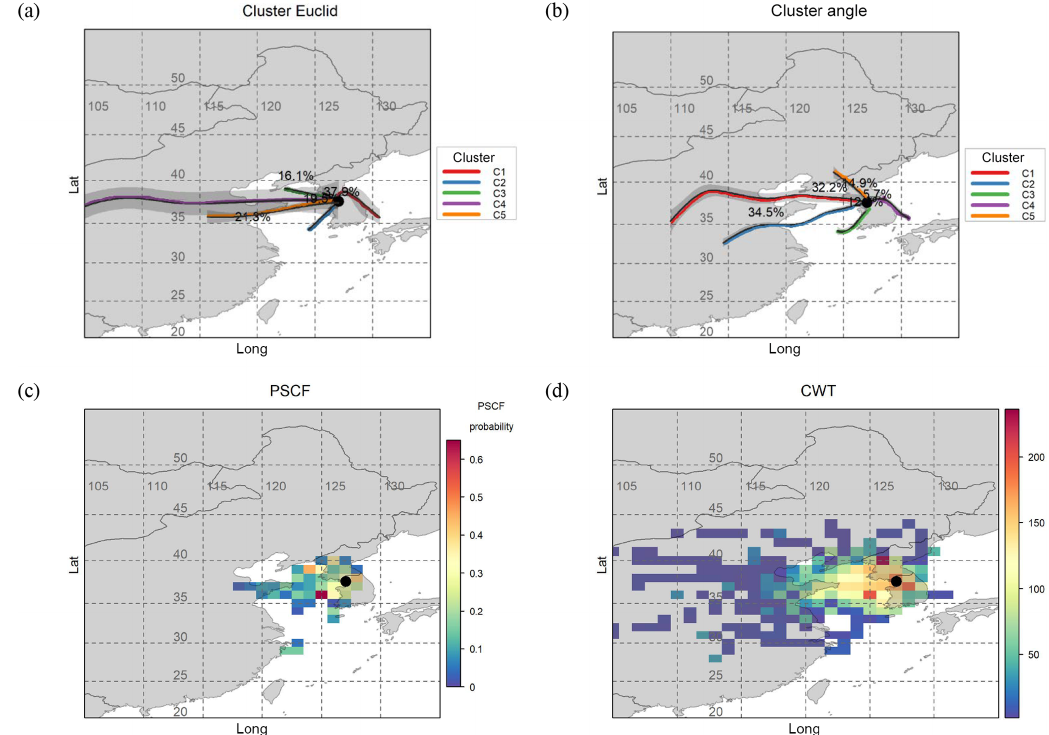
Figure 12. (a) Trajectories clustered by the Euclidian distance function, (b) trajectories clustered by the angle distance function, (c) the potential source contribution factor plot, and (d) the concentration-weighted trajectory